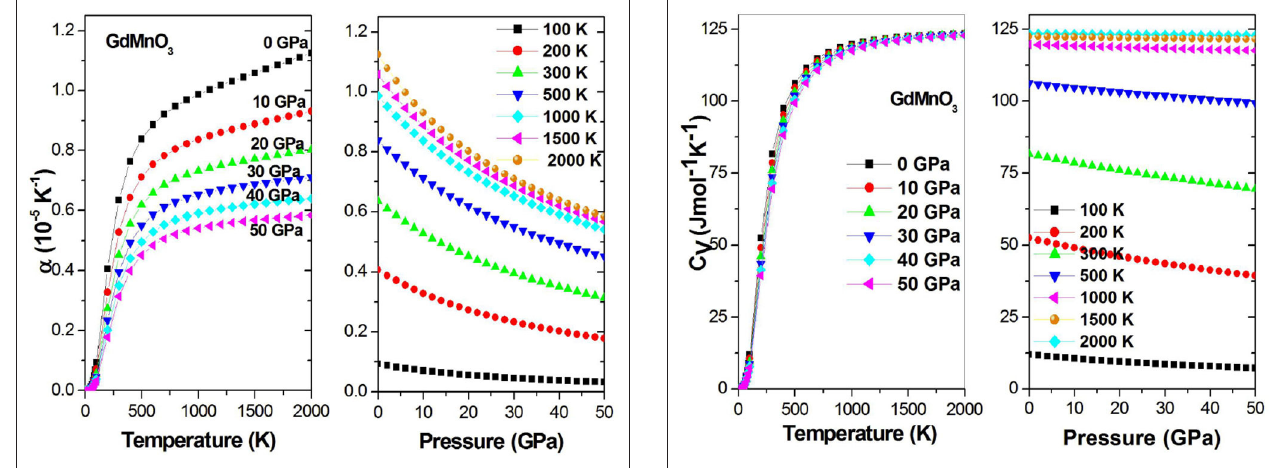
FIGURE 8 | α V as a function of the temperature (pressure) at different given pressures (temperatures).